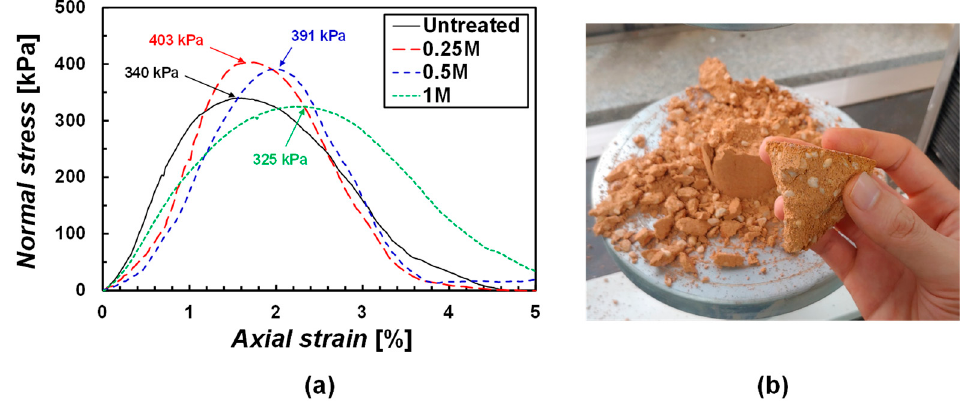
Figure 7. ( a ) Uniaxial compression test results for mixing method and ( b ) untreated specimen after compression test.